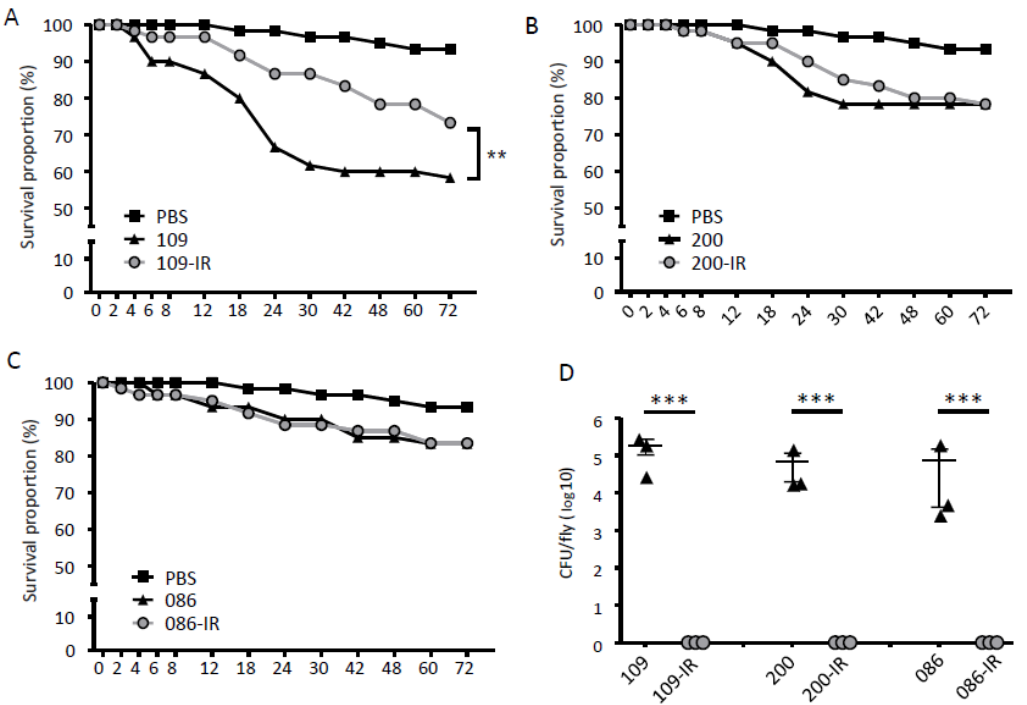
Figure 4. Results of fruit fly infections. ( A – C ) Survival of flies infected with TGC-S and TGC-IR strains. Fifteen flies were infected with each bacterial strain in mid-log phase (OD 600 = 0.5). ( D ) The number of surviving colonies of bacterial strains in the flies after 72 h of infection. The dots indicate the number of CFUs in a single fly. ***, p < 0.0001.